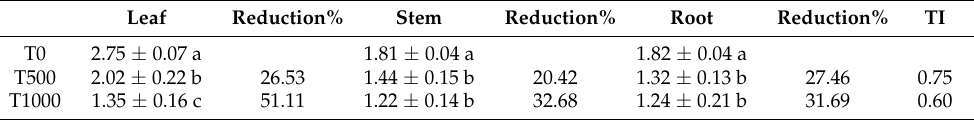
Table 2. Mean harvest dry weights (g) of the component parts, the reduction ratio, and the tolerance index (TI) in R. chinensis under different treatments. Each value represents the mean of three replicates ± SD; Different letters indicate significant difference between the treatments ( p <